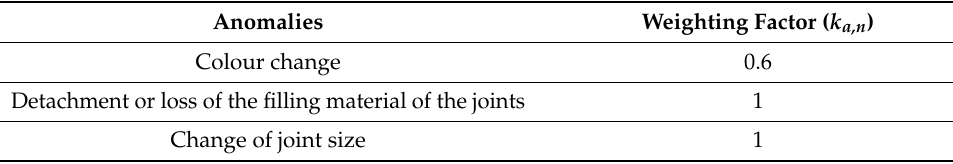
Table 6. Weighting factors associated to joint anomalies.